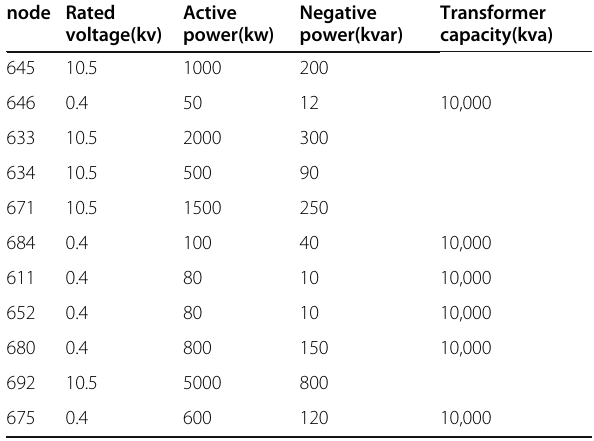
Table 10 Load parameters in the IEEE13 node model node Rated Active Negative voltage(kv) power(kw) power(kvar)